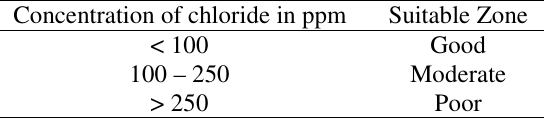
Table 4. Suitability of drinking quality of chloride ions